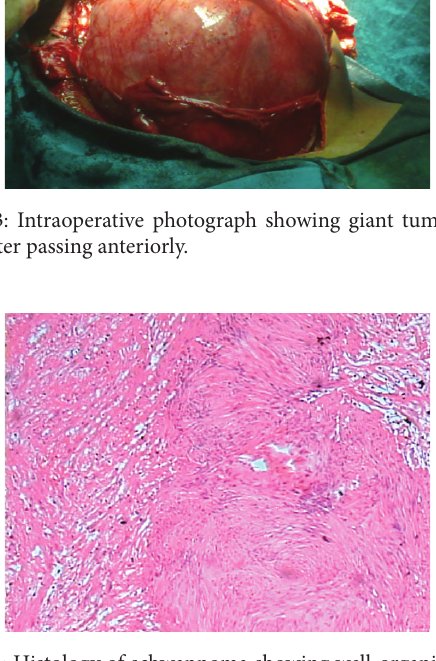
Figure 4: Histology of schwannoma showing well-organised spin- dlecellsinapalisadepattern(AntoniA)ontherightandlesscellular area (Antoni B) on the left.